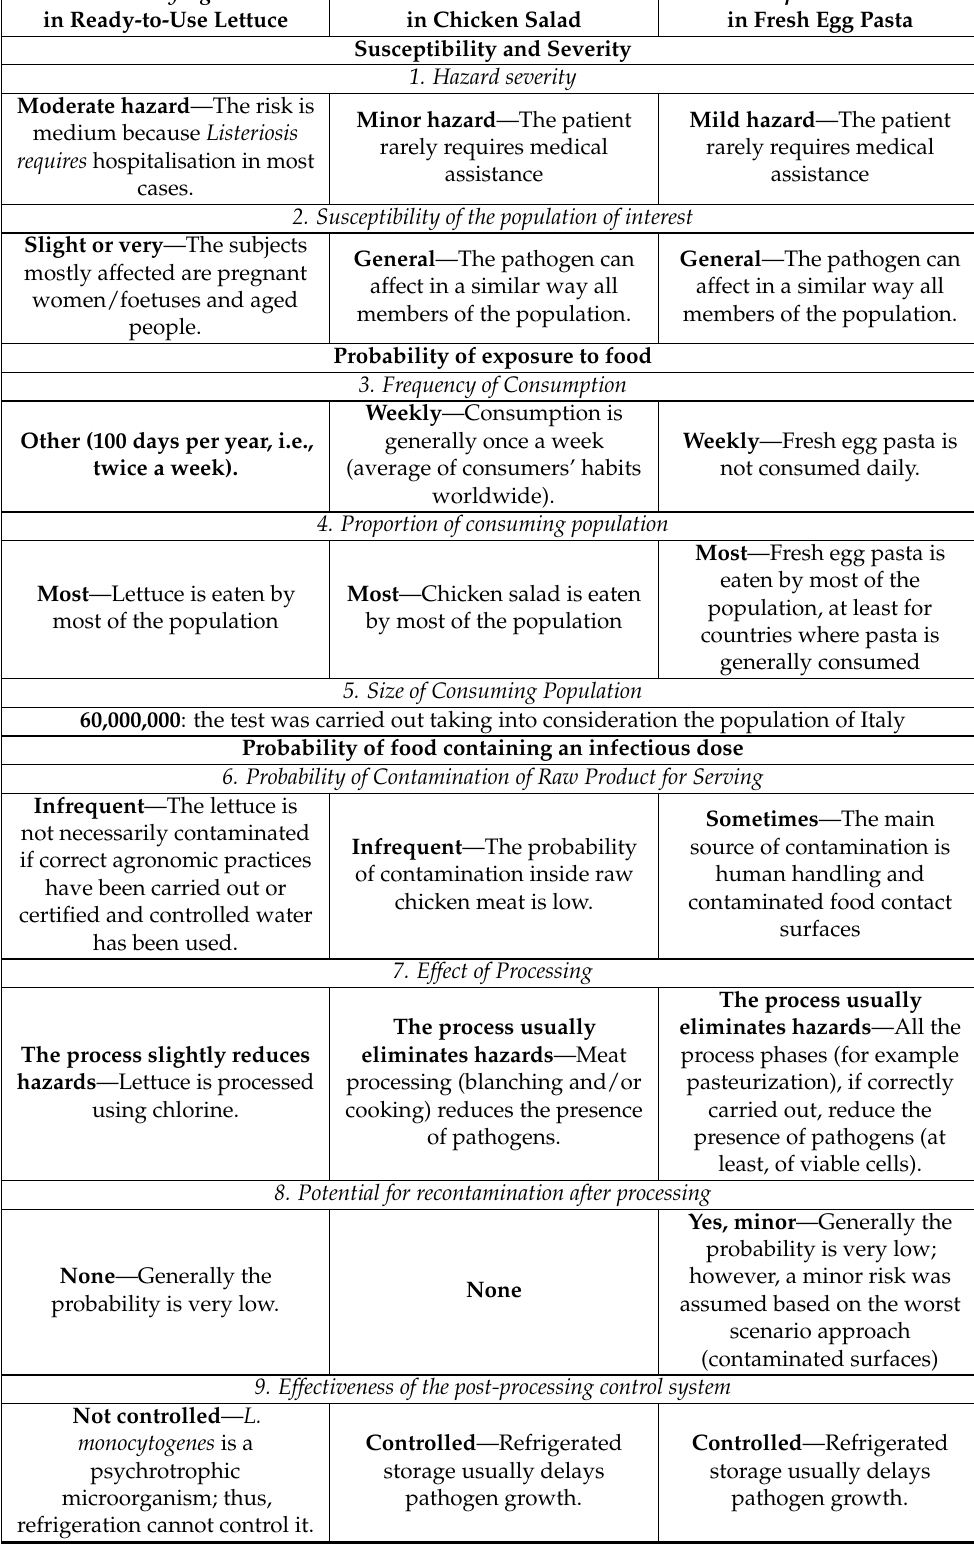
Table 5. Answers to the questions in Risk Ranger. Answers given following authors’ knowledge and information found in references [33–35]. Simulation was performed for a general audience; the exception was for question 5 (size of consuming population), where the input was based on the Italian population to gain realistic